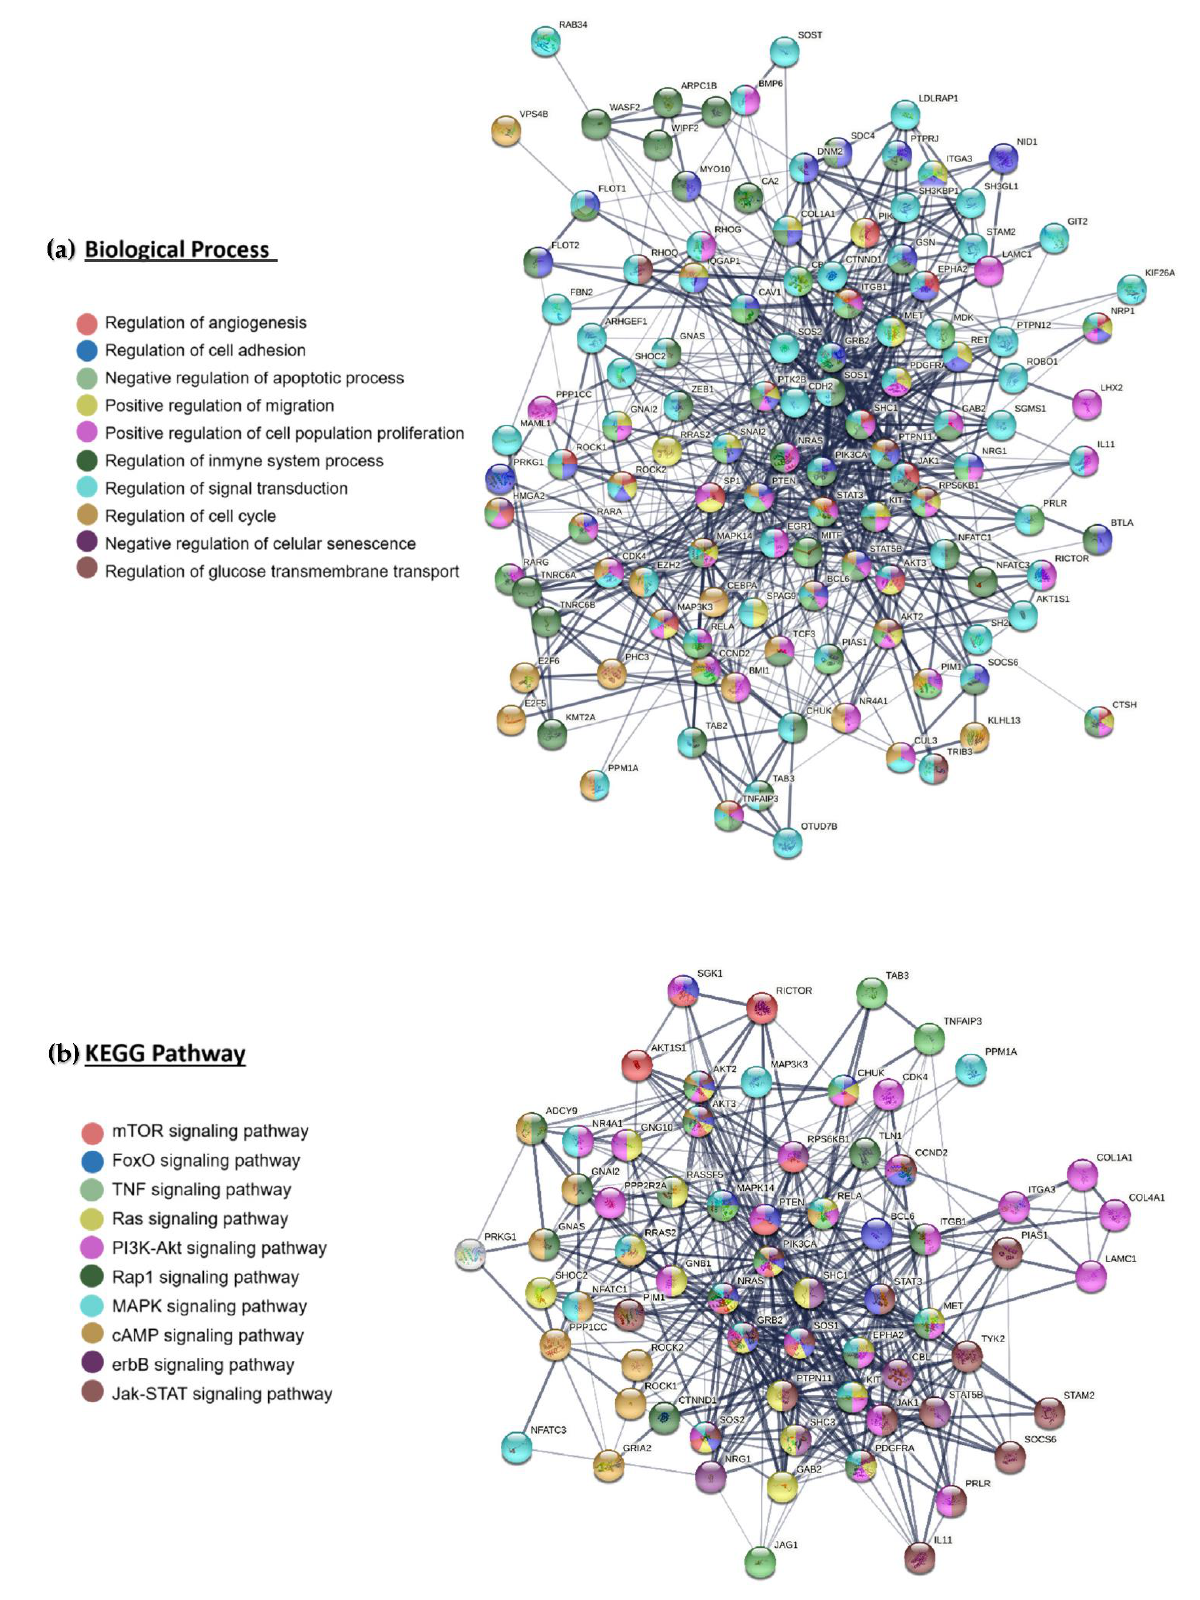
Figure 4. Interactions between proteins regulated by miR-23b-3p, miR-124-3p, or miR-218-5p. ( a ) 121 proteins participate in the regulation of biological processes and ( b ) 67 proteins interact to regulate signaling